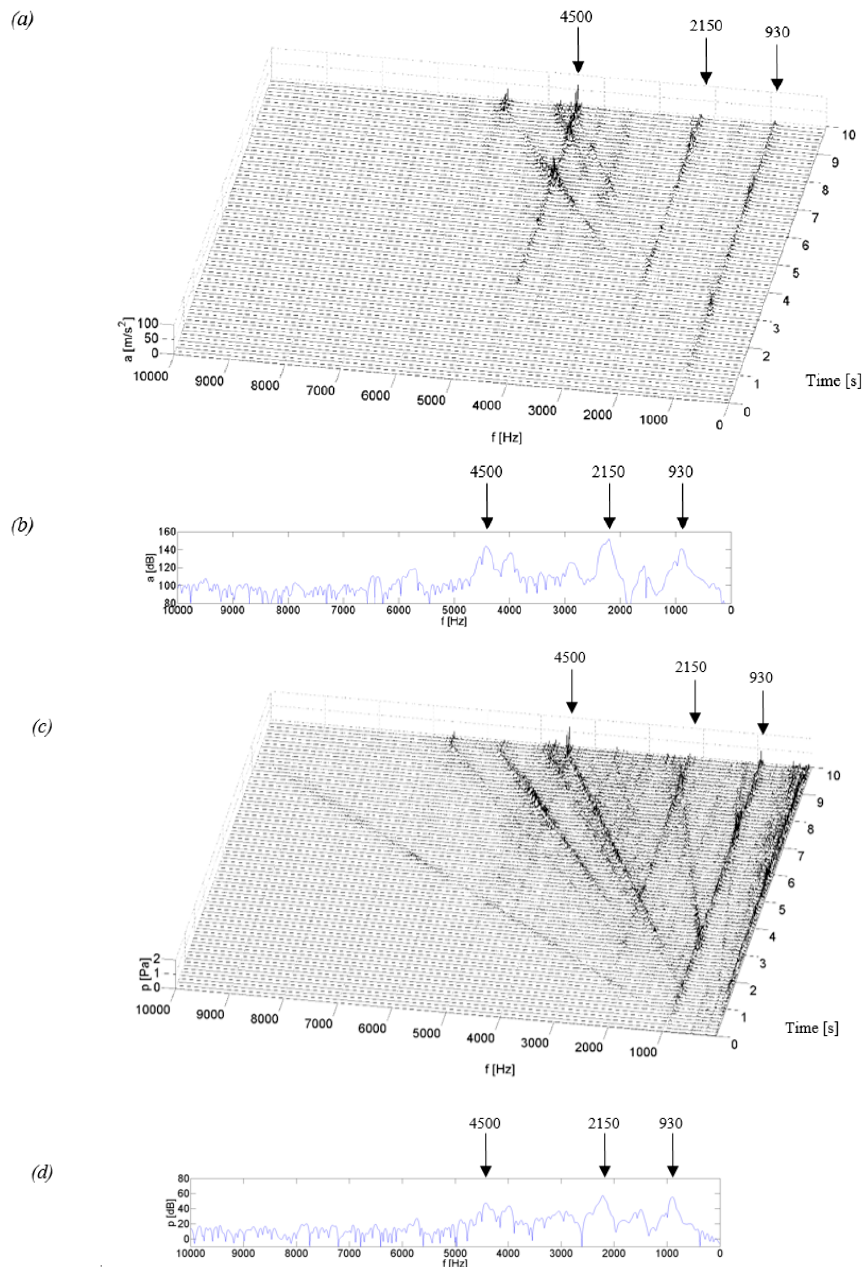
Figure 4. Test results for the Steel housing: ( a ) time-frequency distributions of vibration acceleration (P_5), ( b ) vibration response (P_5), ( c ) time-frequency distributions of acoustic pressure ( H ), ( d ) acoustic response ( H ).